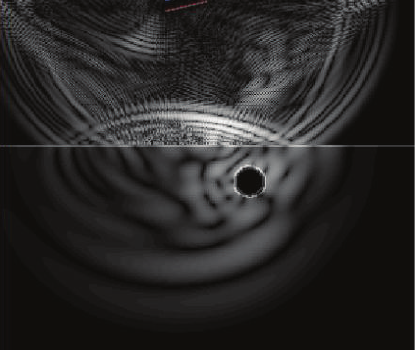
Figure 6: Snapshot of the displacement field for the case of loose